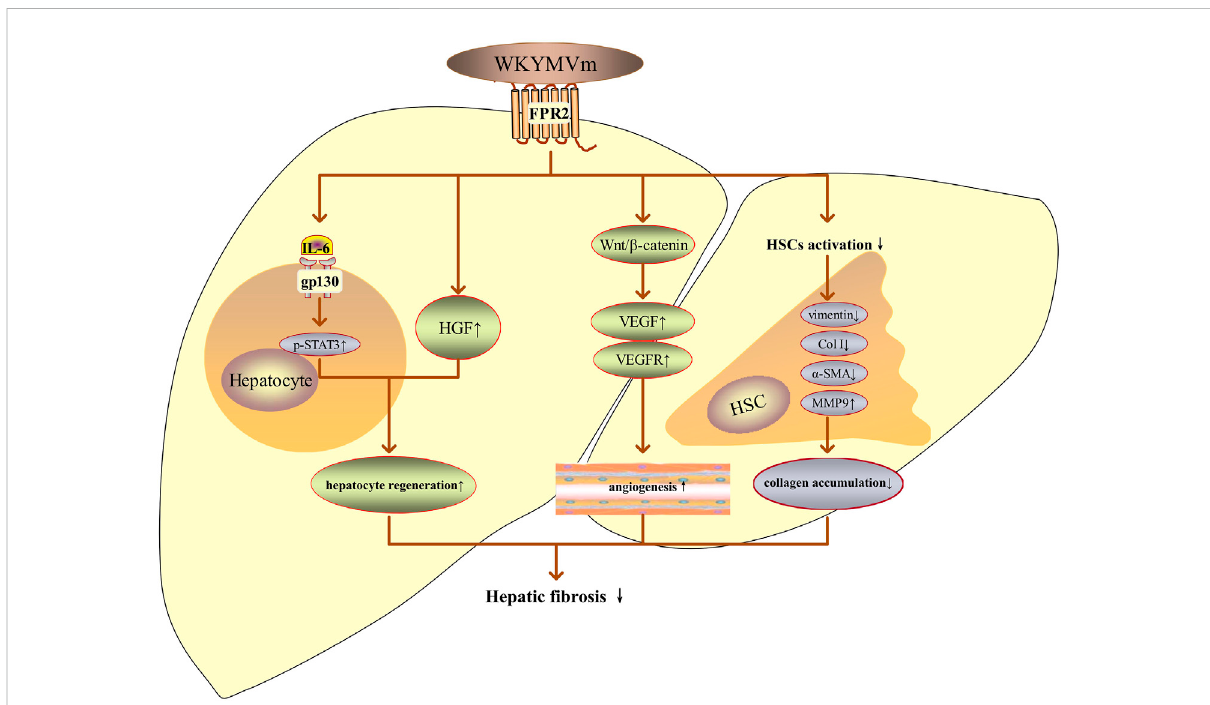
FIGURE 4 WKYMVm and hepatic fi brosis. WKYMVm improves hepatic fi brosis by decreasing the collagen accumulation, promoting angiogenesis and hepatocyte regeneration. IL-6, interleukin-6; gp130, glycoprotein 130; p, phosphorylation; STAT3, signal transducer and activator of transcription 3; HGF,hepatocytegrowth factor; VEGF,vascularendothelial growth factor; VEGFR, vascular endothelial growth factor receptor; HSC, hepatic stellate cell; Col I, type I collagen; α -SMA, alpha-smooth muscle actin; MMP9, matrix metalloproteinase 9. ↑ , increase; ↓ ,